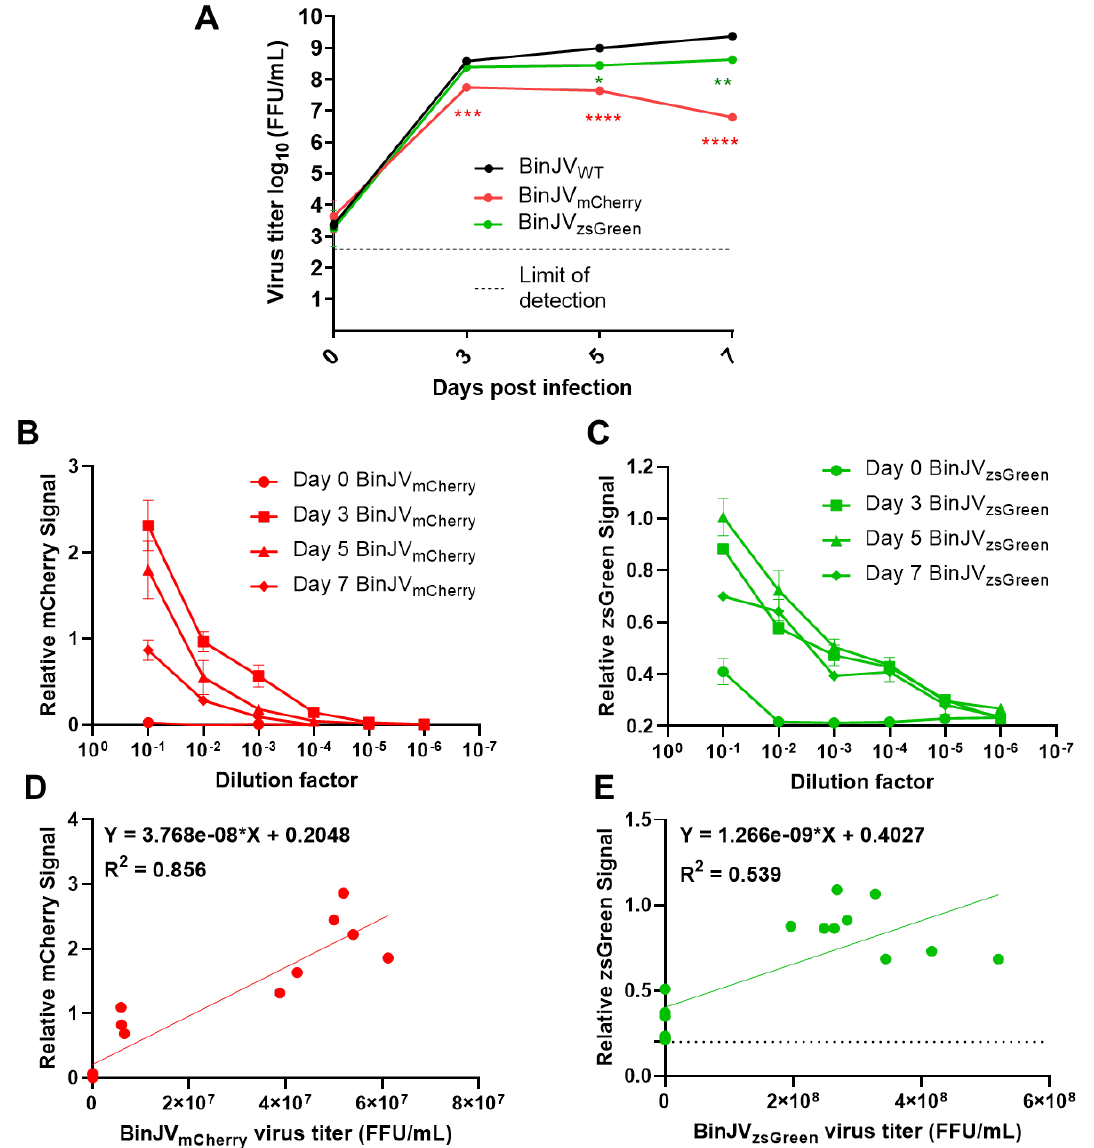
Figure 2. Binjari virus reporters grow to high titres in insect cells and are semi-quantifiable using fluorescent microplate readers. ( A ) Growth kinetics of P 1 CPER generated BinJV viruses in C6/36 cells infected with WT or reporter BinJV. Cells were infected at MOI = 0.1, culture supernatant were sampled at the indicated time point, and titers were determined using iPA on C6/36 cells. Values are the means from three biological replicates ± SEM. Statistical analysis was a two-way ANOVA with Dunnett’s correction. All comparisons were to WT; * p < 0.05, ** p < 0.01, *** p < 0.001, **** p < 0.0001. Relative fluorescence units for serially diluted C6/36 culture supernatant taken from the growth kinetics and reinfected on C6/36 cells showing ( B ) BinJV mCherry signal and ( C ) BinJV zsGreen signal. The linear relationship between matched samples of fluorescence units taken from the 10 − 1 dilution and FFU/mL assay of ( D ) BinJV mCherry ( E ) BinJV zsGreen viruses. For the simple linear regression analysis, 15 matched samples were used. The baseline signal for zsGreen is given as a dotted line. The linear regression function and the coefficient of determination (R 2 ) are given on both graphs.